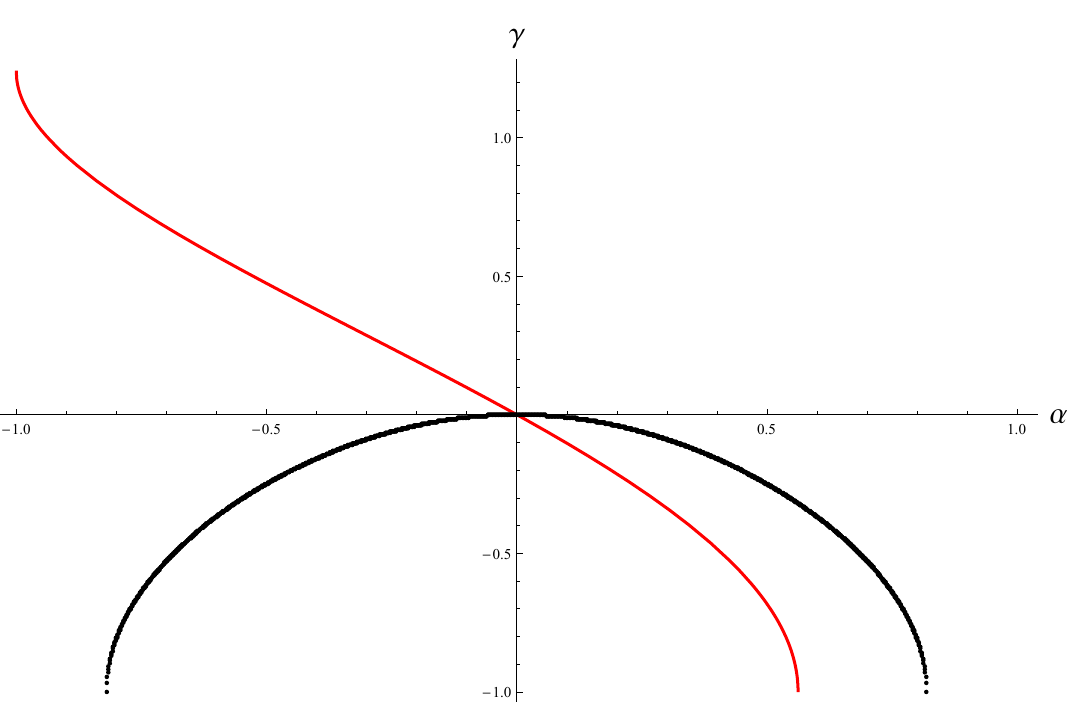
Figure 1 . Anomalous dimension of tr (cid:30) 2 (black) and tr (cid:30) i (cid:30) j 6 = i (red) in the hexagonal (cid:12)shnet model i as a function of the only meaningful combination of the couplings, (cid:11)